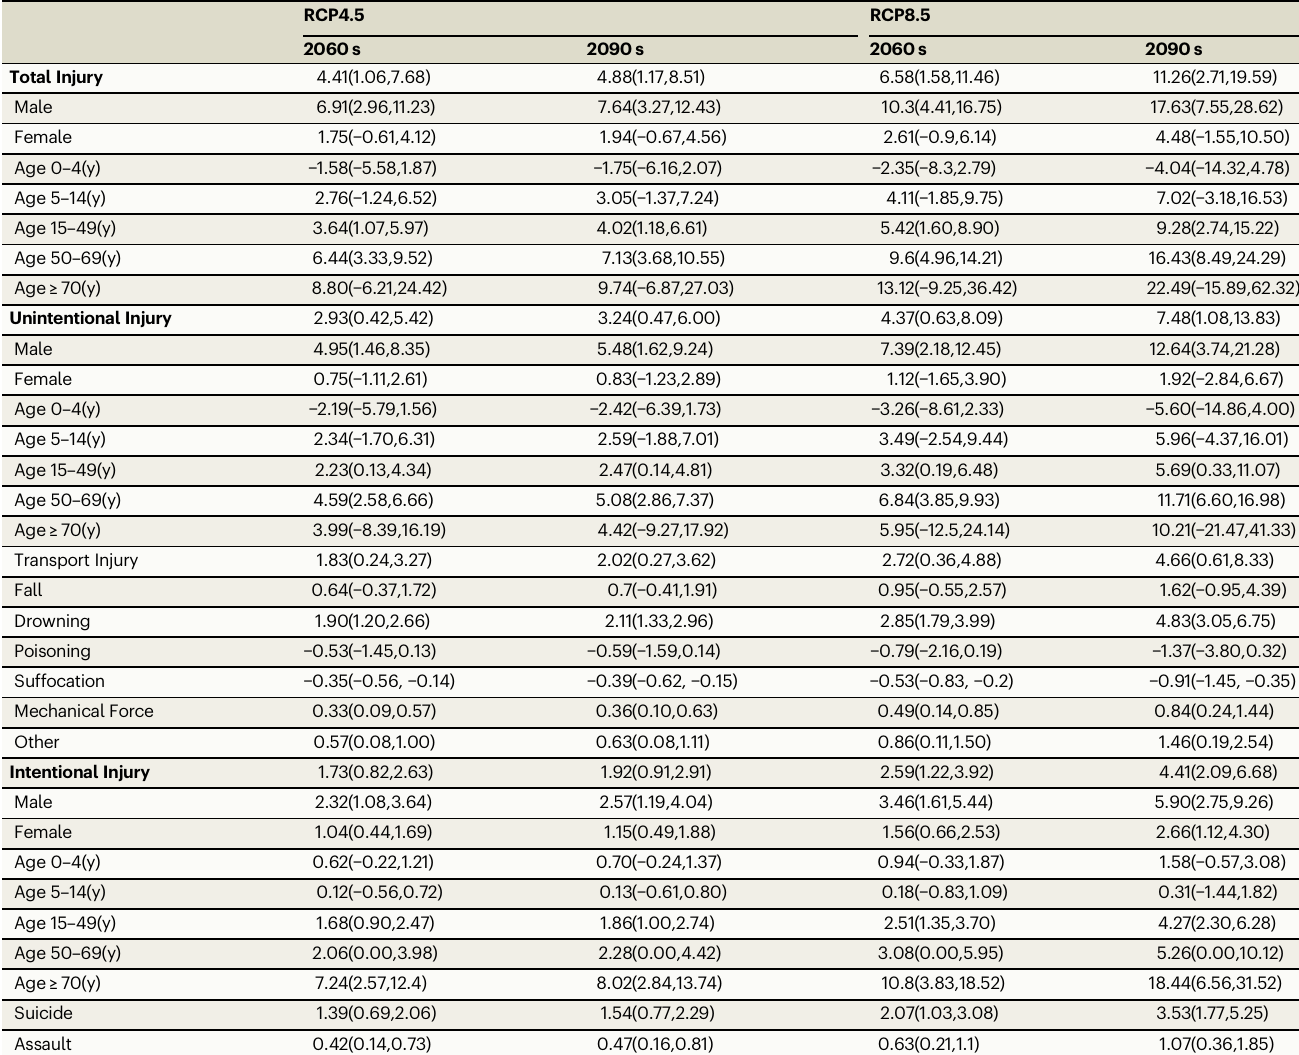
Table 2 | The projected mortality rate (per 100,000) of injury attributable to temperature change in the 2060 s and 2090 s compared to the 2010s under different RCP scenarios in